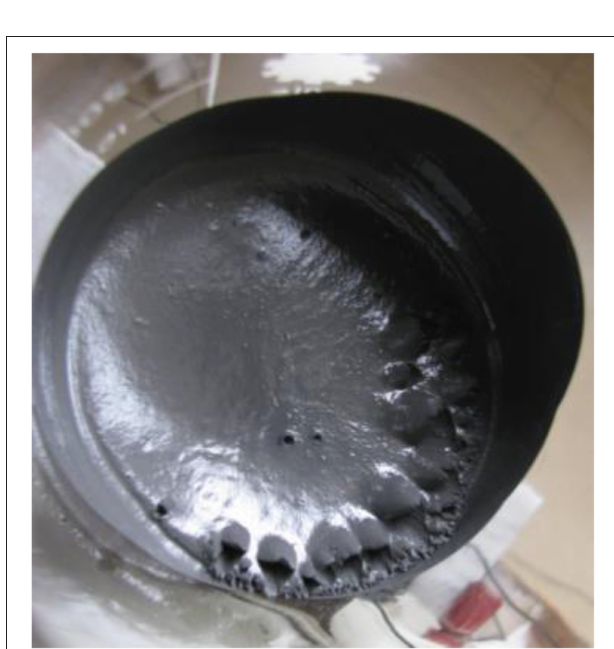
FIGURE 8 | The MRF.